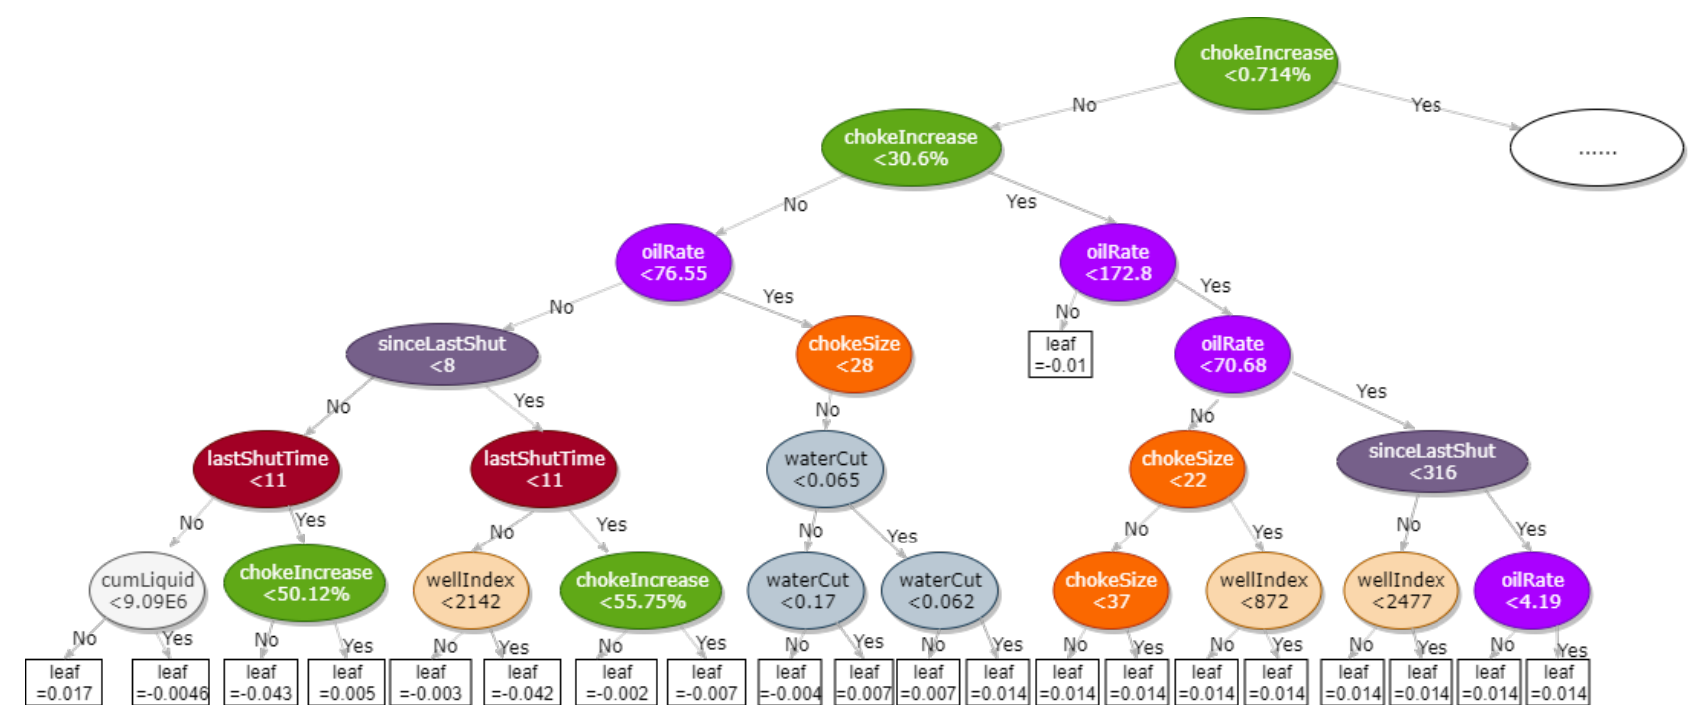
Figure 11. Trained CART structures demonstrating key features for interpretations.